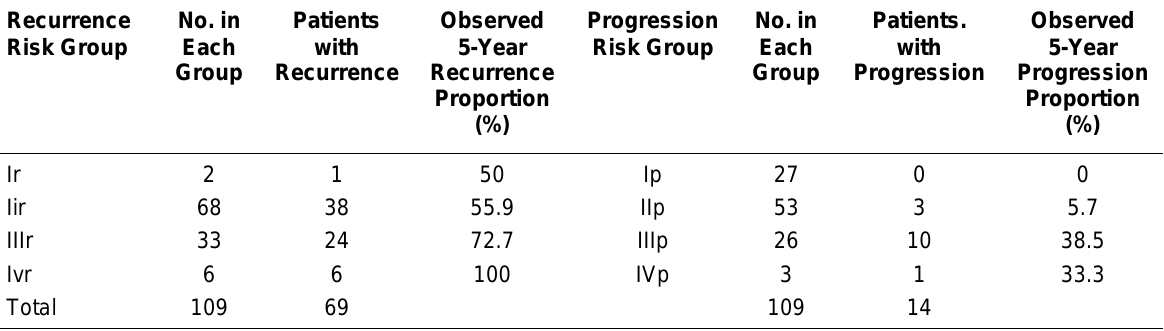
Number of Study Group Patients According to EORTC Risk Group Scores for Recurrence and Progression and Observed Proportion of 5-Year Recurrence and Progression in the Study